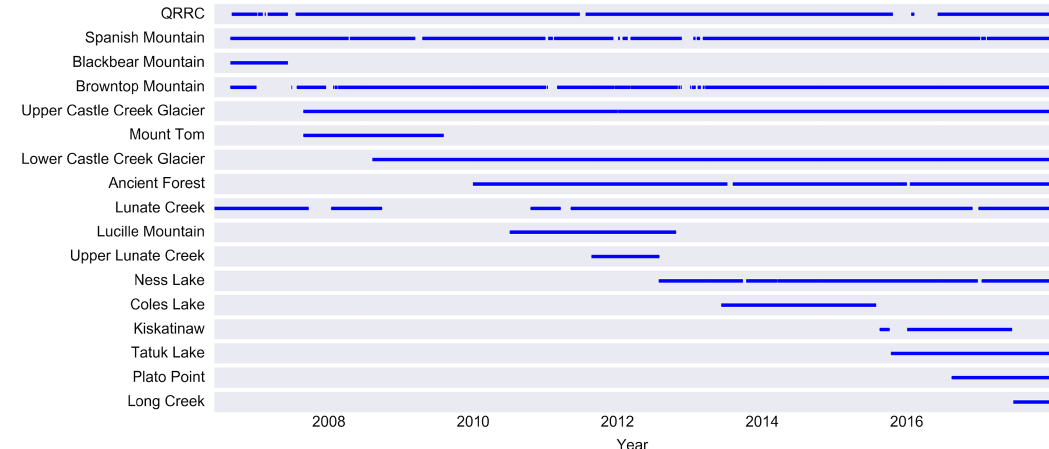
Figure 5. Operating periods for active and inactive CAMnet weather stations (1 January 2006–31 December 2017), deduced by analyzing the battery voltage required to power each station’s data logger and instruments. Gaps in datasets occur due to a variety of reasons outlined in Sect. 5.1. Note that data may not be available for all instruments even when a station is operational (e.g., the icing of anemometers during